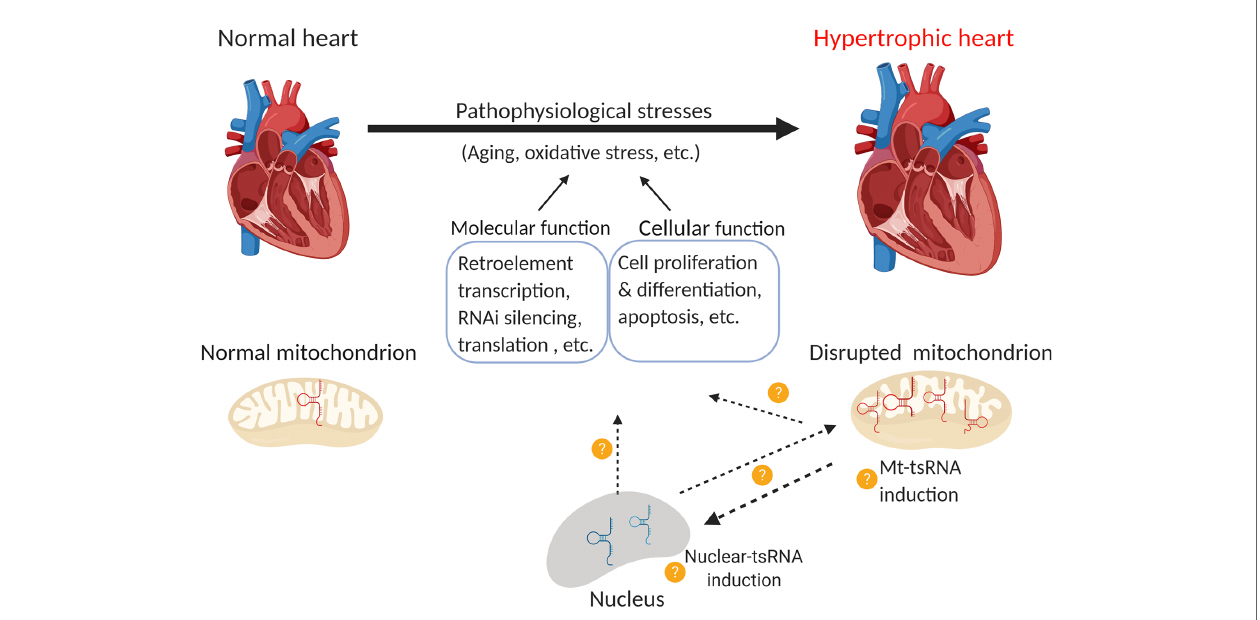
FIGURE 3 | Function of nuclear and mitochondrial tsRNAs in cardiac hypertrophy. Pathological stress ( e.g. oxidative stress) leads to the development of cardiac hypertrophy. Emerging evidence indicates that the disruption of mitochondrial tsRNAs plays a role in this process. Consequently, it would be interesting to investigate the following questions: 1) Whether nuclear-tsRNAs or mt-tsRNAs are induced or dysregulated during cardiac hypertrophy, 2) Whether any of these tsRNAs exert molecular functions such as the regulation of retro-element transcription, RNAi silencing, and translation, or cellular functions such as cell proliferation, differentiation, and apoptosis, and 3) Whether nuclear-tsRNAs and mt-tsRNAs shuttle between the nucleus and mitochondria, and if their function in different organelles affects cardiac hypertrophy (Created with